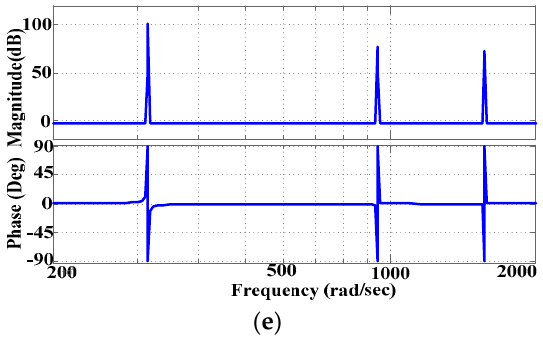
Figure 9. Zoom into system performance applying PCHC; CSI grid current, and grid current with its FFT analysis at ( a , c ), high power level, and ( b , d ), low power level, and ( e ) Bode plot.